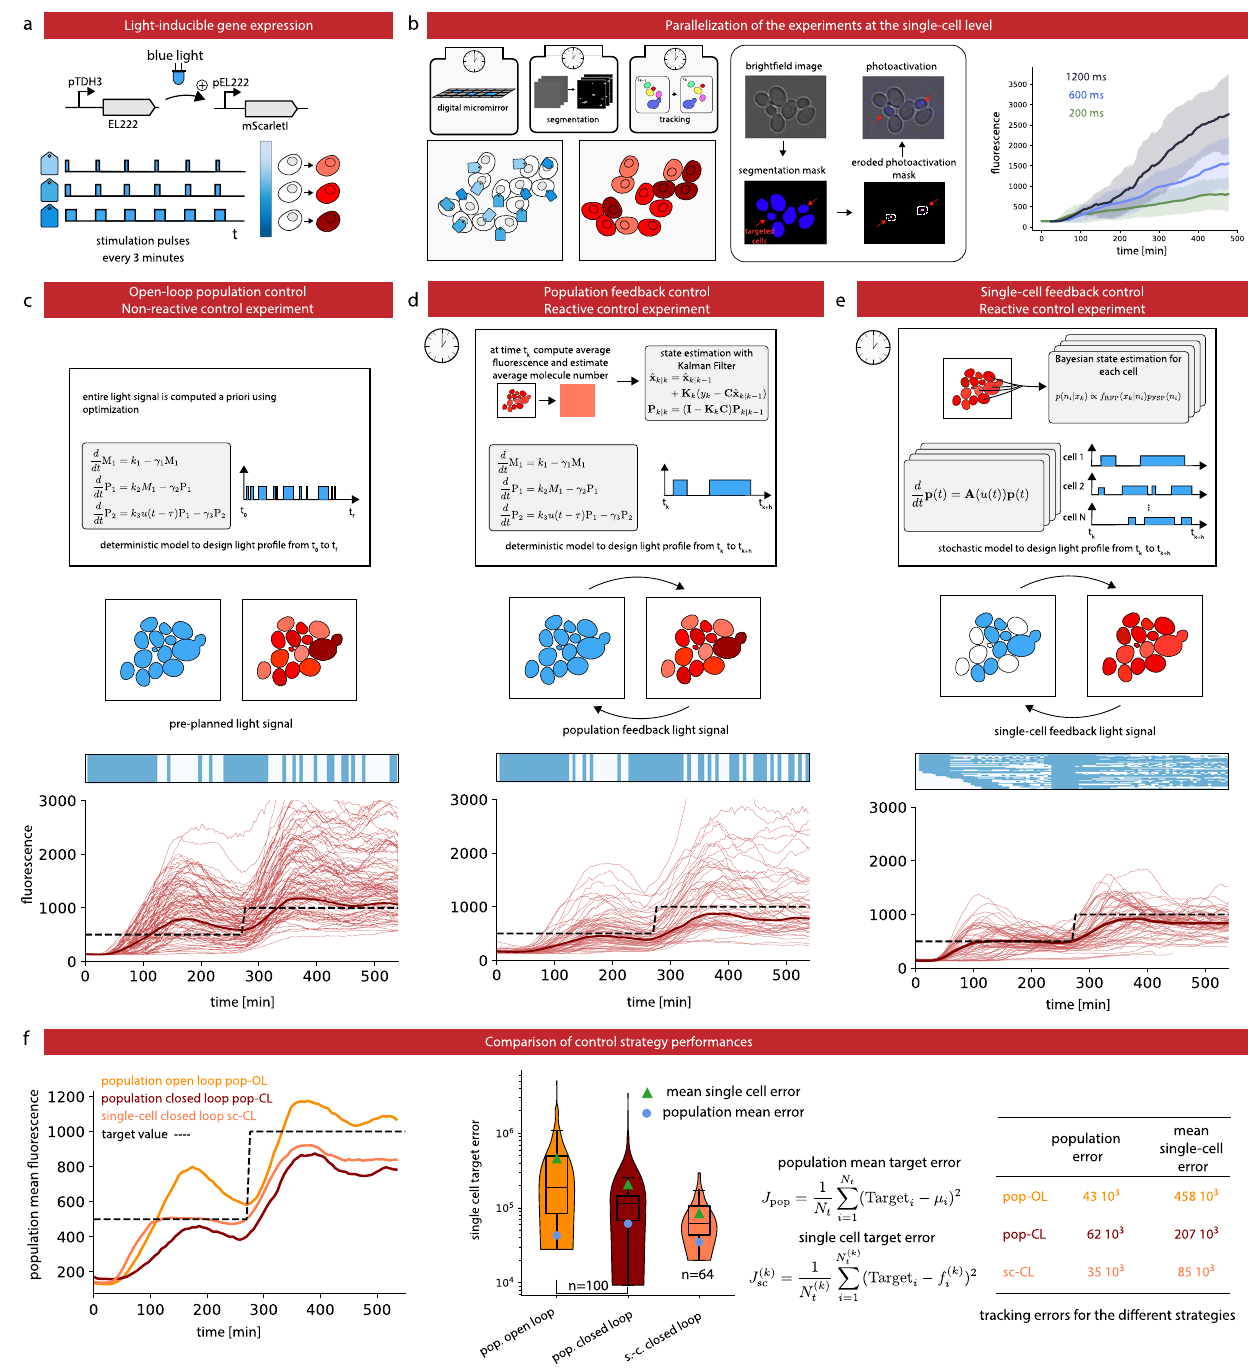
Fig. 3 Control gene expression at the single cell level in yeast. a The red fl uorescent protein mScarletI is placed under the control of the light-responsive transcription factor EL222. b To ef fi ciently characterize cell responses to light stimulations, cells in the fi eld of view are partitioned in three groups, each group being stimulated with a different temporal pro fi le. Bright- fi eld images are segmented and cells are tracked. Then, based on their groups, cells are stimulated during the appropriate time with eroded masks (see Supplementary Fig. 5). Therefore, characterization experiments are run in parallel thanks to the DMD and our capacity to segment and track cells in real time. The temporal evolution of the mean mScarletI fl uorescence of the cells in the three groups is shown with envelopes indicating one standard deviation. Single-cell trajectories and replicates are provided in Supplementary Fig. 6. c Open-loop control experiment in which a model of the response of the cell population is used to precompute a light stimulation pro fi le that drives the cell population to the target behavior. The application of the light pro fi le leads to signi fi cant deviations from the target of the individual cell trajectories. d Closed-loop control experiment in which the same model is used jointly with real-time observations of the population state to decide which light pro fi le to apply to all cells, using a receding horizon strategy. e A stochastic model of individual cell response is used jointly with single-cell observations to decide which light pro fi le to apply to each cell. f The different strategies have similar performances to drive the mean fl uorescence to its target, but the single-cell feedback strategy is signi fi cantly better to drive individual cells to their target pro fi les. Box plots indicate the lower quartile, the median, and the upper quartile of the target error, with the whiskers corresponding to 1.5 interquartile ranges. Each control experiment was replicated two times. NATURE COMMUNICATIONS| (2022) 13:2199 |https://doi.org/10.1038/s41467-022-29888-z|www.nature.com/naturecommunications